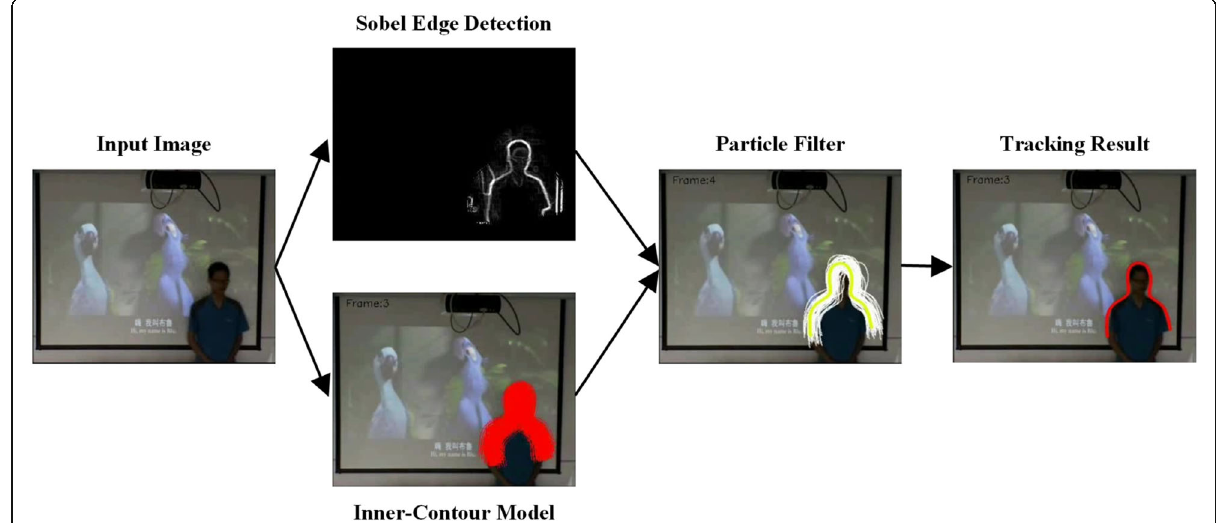
Fig. 1 The pipeline of the proposed